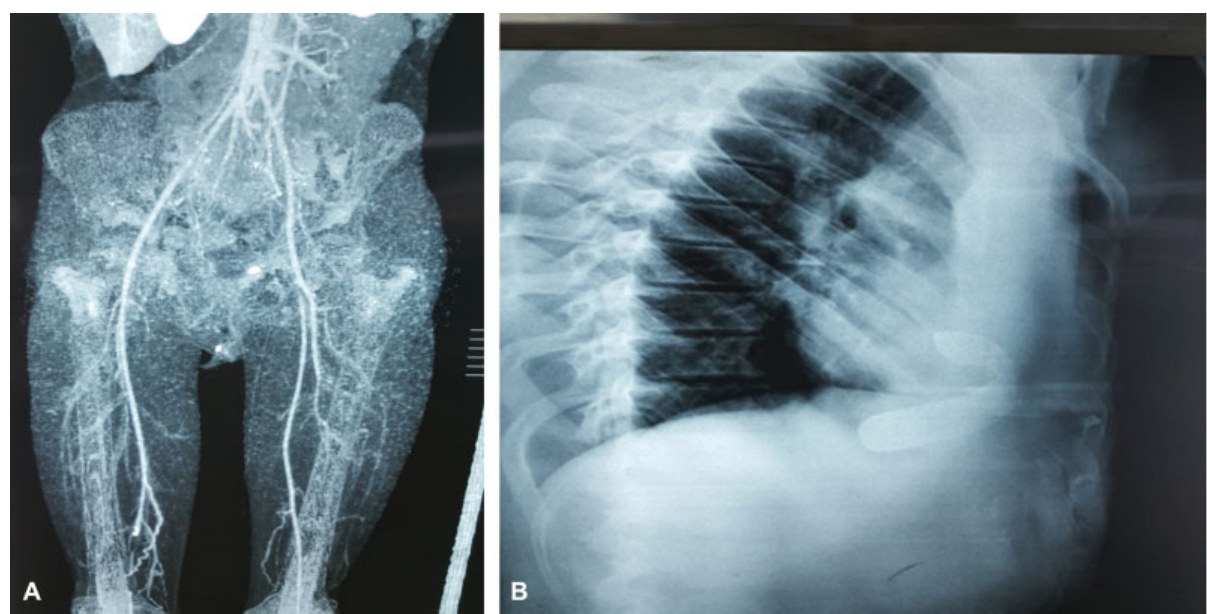
Fig. 2 ( A ) Lower limb angiography showing partial occlusion of both femoral arteries and absent circulation in the popliteal arteries; ( B ) the lateral X-ray of the remaining strut.